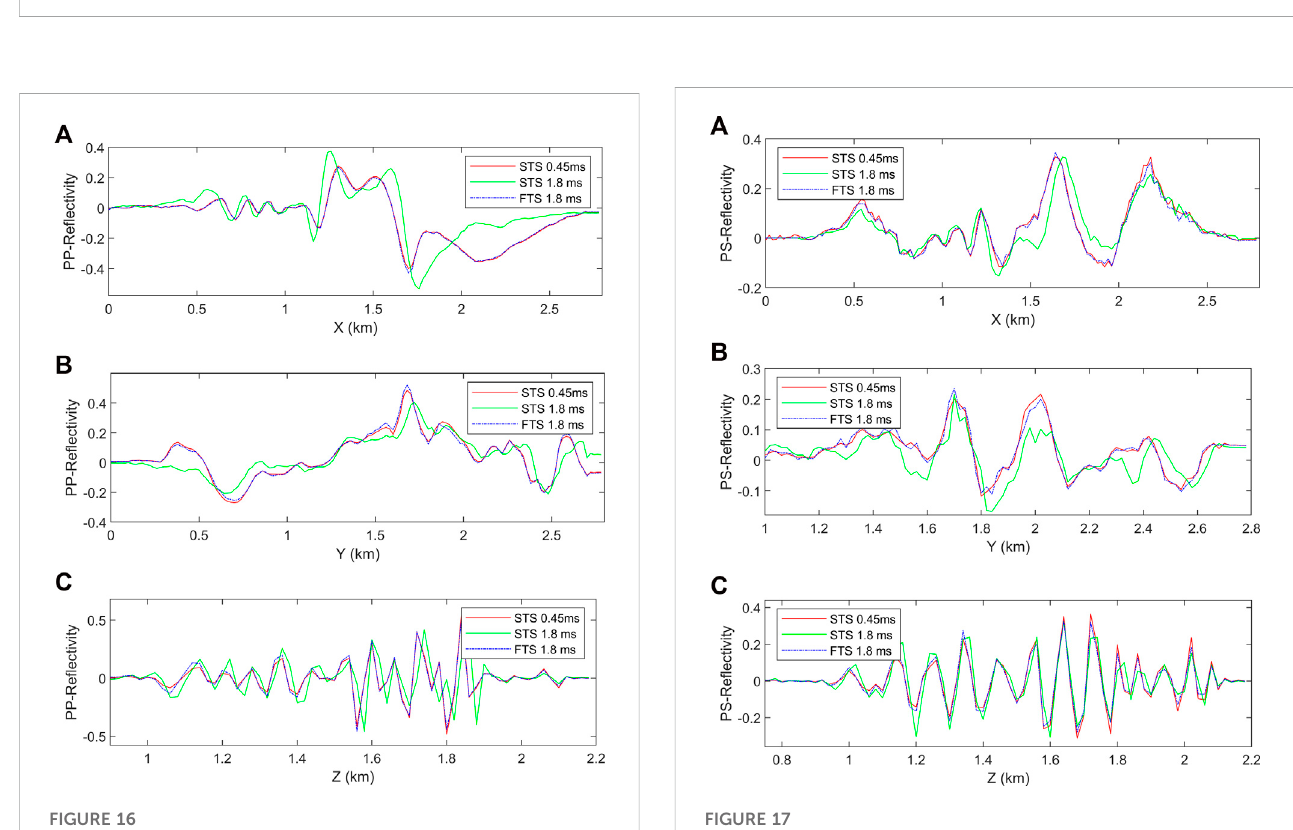
Frontiers in Earth